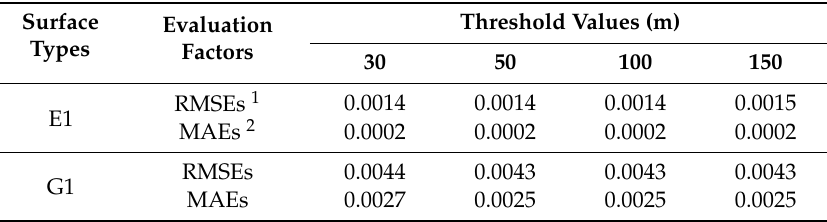
Table 4. Root mean standard errors (RMSEs) and mean absolute errors (MAEs) for the C calculated by the proposed algorithms under the di ff erent threshold values on the E1 and G1.